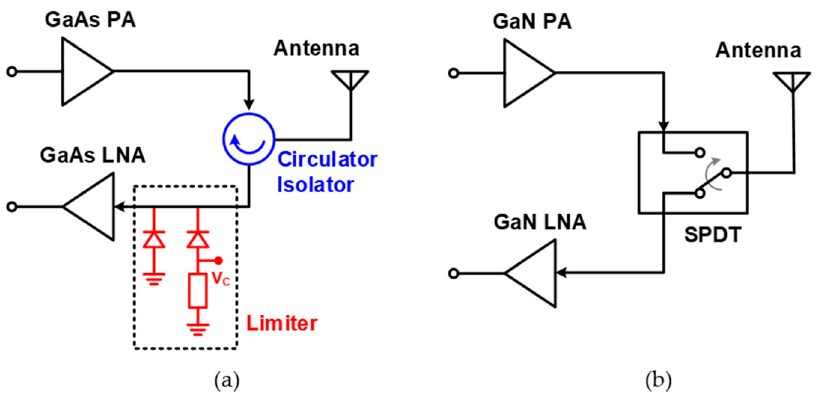
Figure 1. Front ‐ end module configuration using ( a ) GaAs and ( b ) GaN technologies